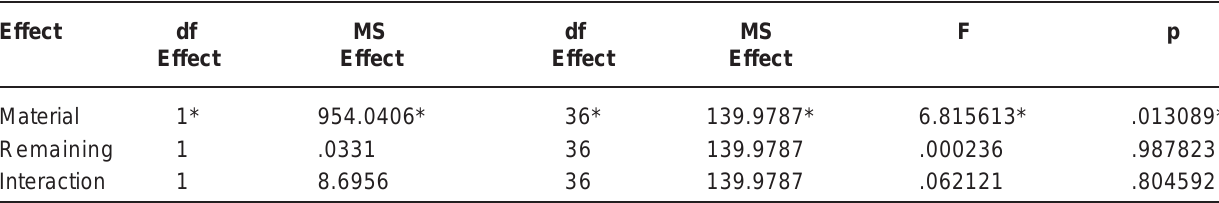
*statistically significant (p<0.05)